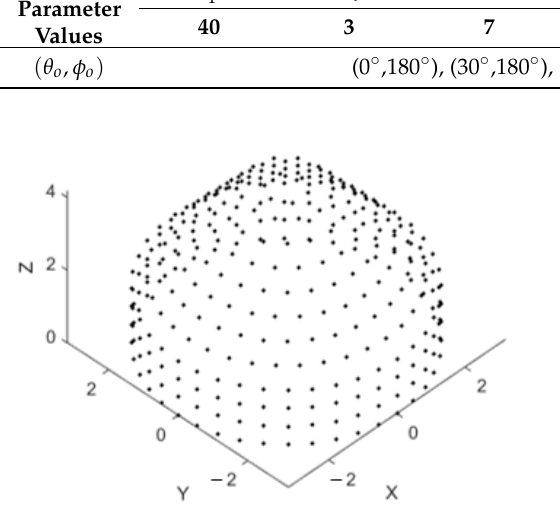
Figure 6. Arbitrary design of uniform CSC 4 antenna array using the parameters shown in Table 3. The axes are normalized to the wavelength.